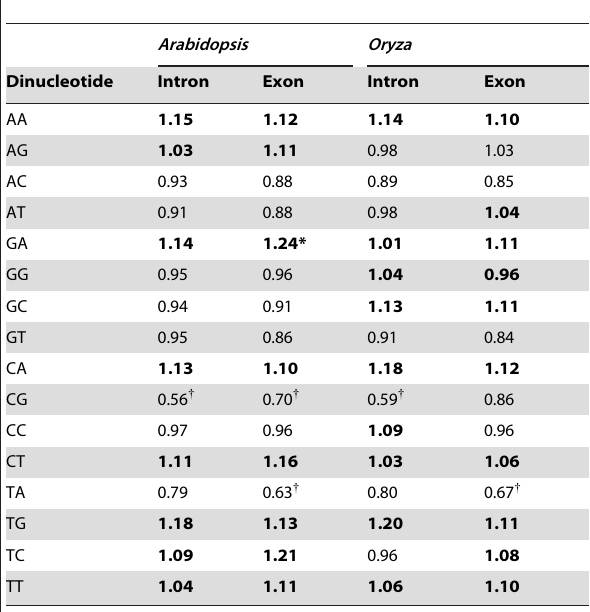
Table 4. Average dinucleotide biases in introns and exons of Arabidopsis and Oryza (bold = overrepresented, plain = underrepresented, *=significantely over-represented, { . = significantely under-represented).